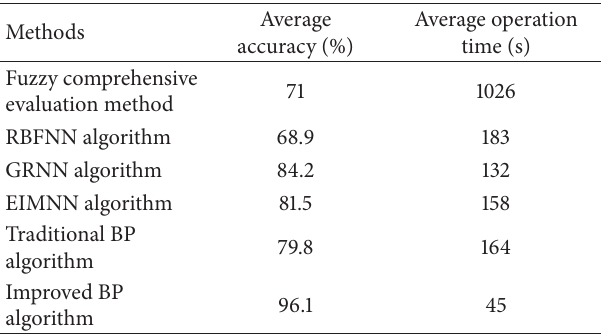
Table 3: The result of comparison of